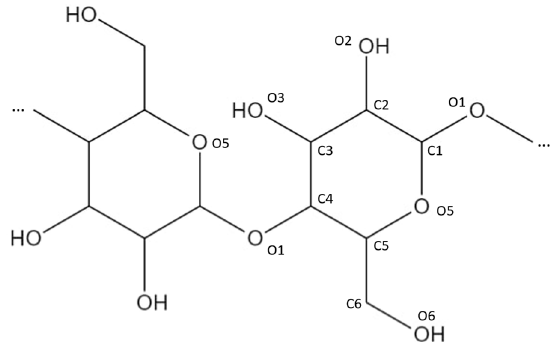
Figure 5. Position and numbering of the carbon and oxygen atoms in the cellulose structure.